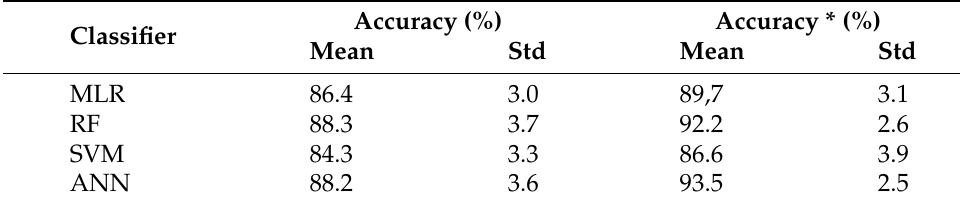
Table 2. Statistical comparison ( k = 20-fold cross-validation) of the achieved accuracies for all trained